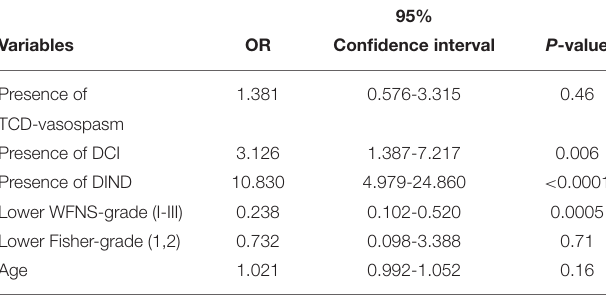
TABLE 3 | Multivariate logistic regression analysis for identification of predictors of DCI-associated